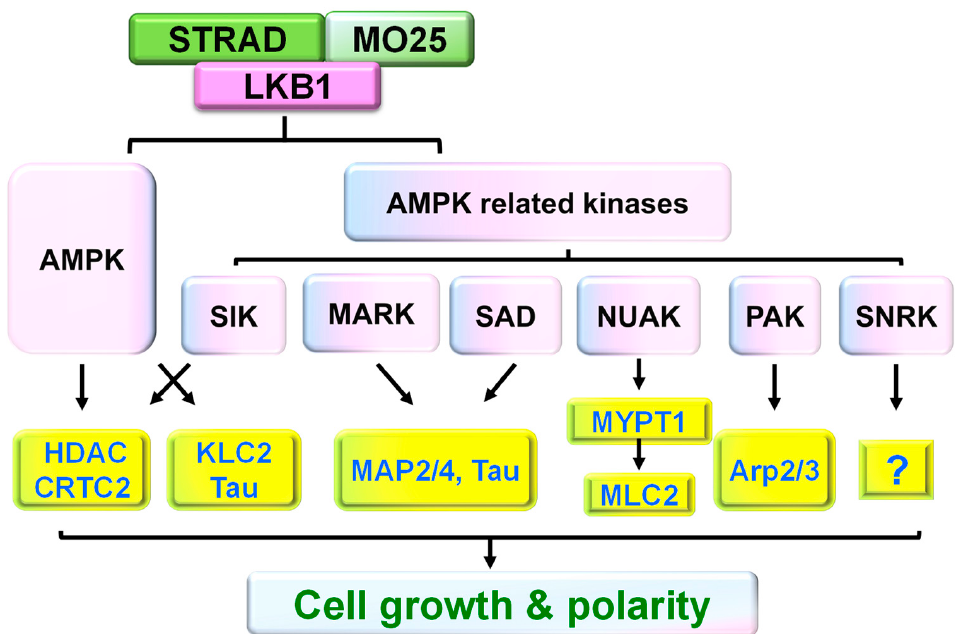
Figure 3. Schematic of phosphorylation of AMPK and AMPK-related kinases by LKB1 complex. LKB1 complex directly phosphorylates and activates AMPK and numerous AMPK-related kinases, including SAD kinases, NUAKs, MARKs, SIK1, and SNRK. These kinases then phosphorylate various downstream substrates to control several cellular functions, including cell growth and polarity. The downstream substrates include HADC (histone deacetylases), CRTC2 (CREB regulated transcription coactivator 2), KLC2 (kinesin light chain 2), Tau, MYPT2 (myosin phosphatase target subunit 2), and Arp2/3. MYPT2 may regulate cell growth through MLC2 (myosin light chain 2). So far, the substrate(s) of SNRK remains